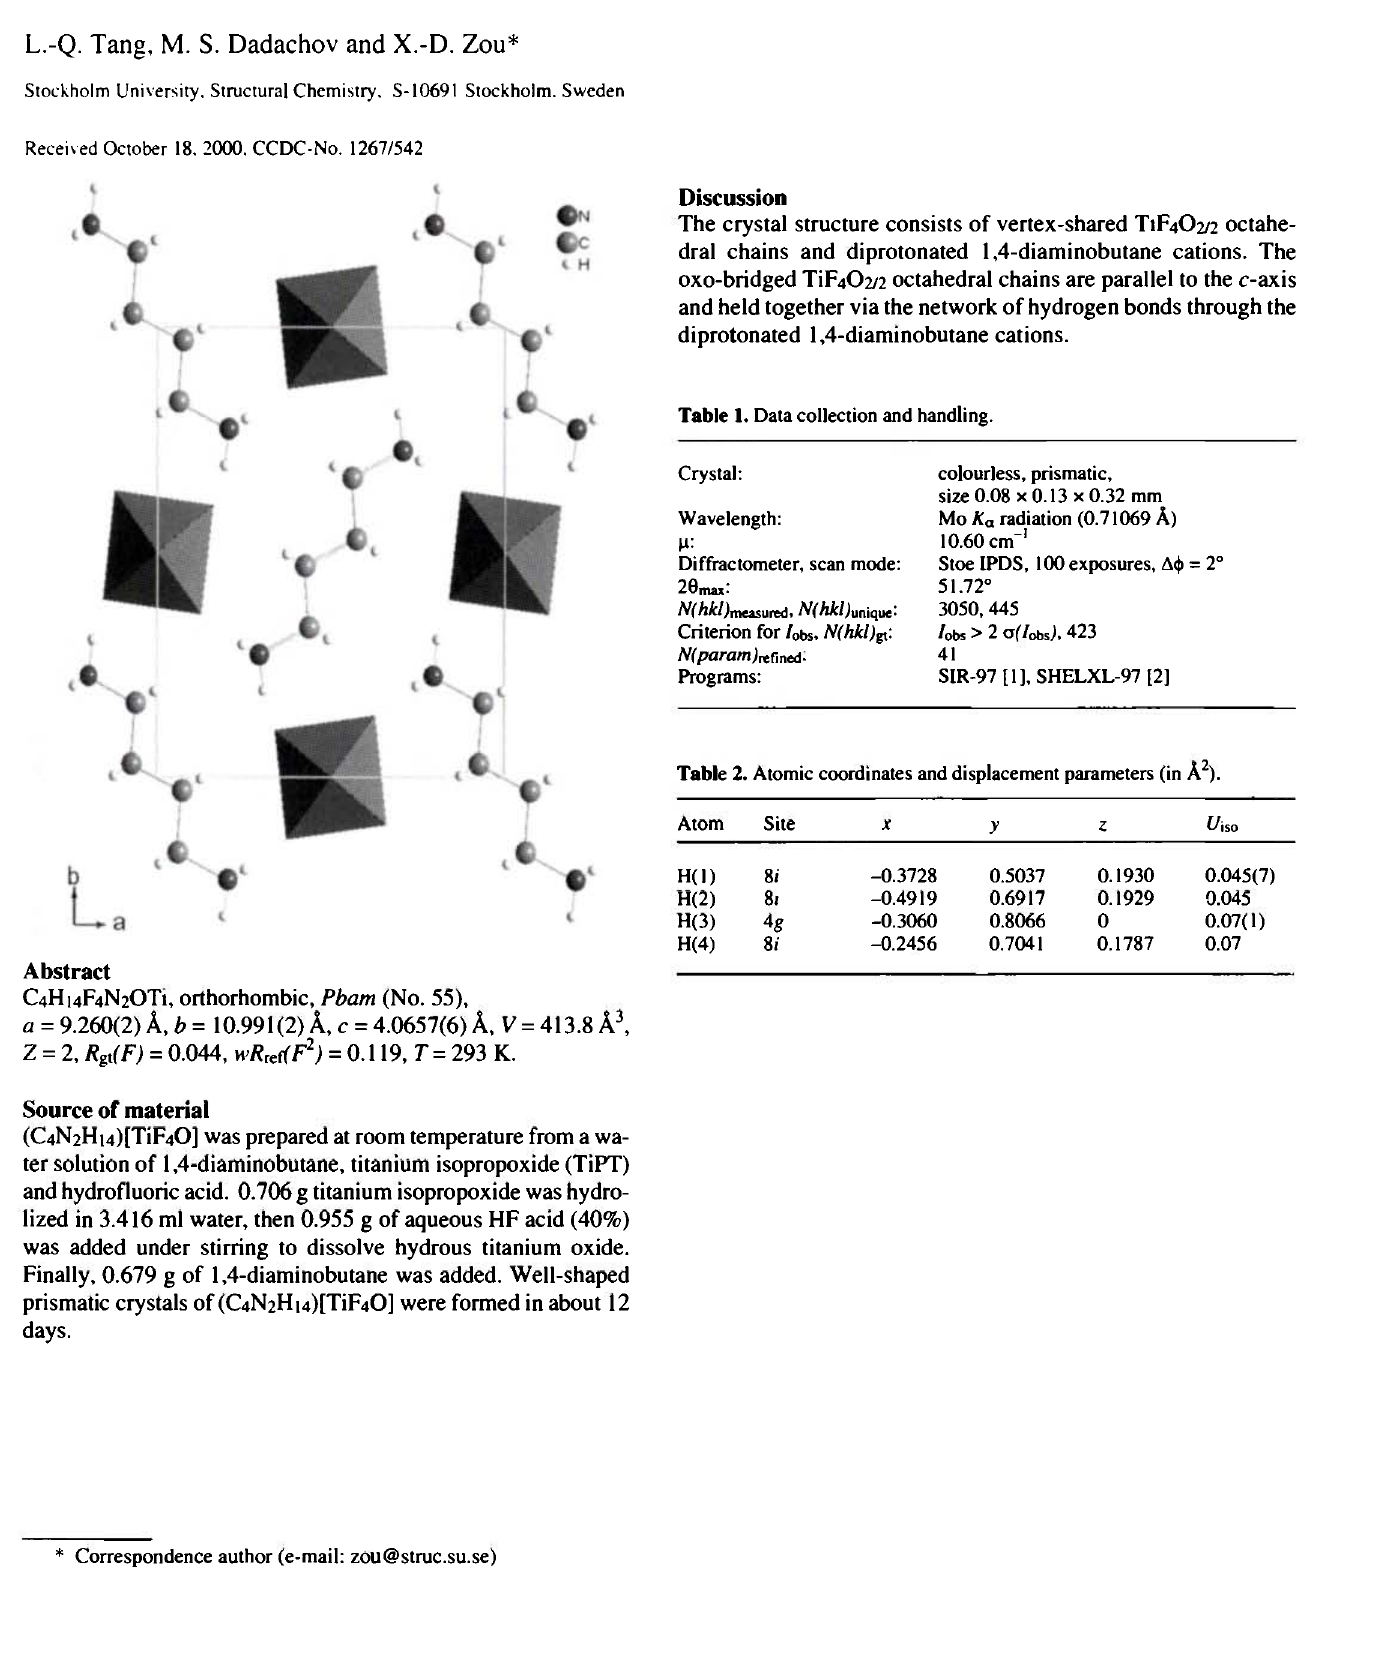
Table 1. Data collection and handling.